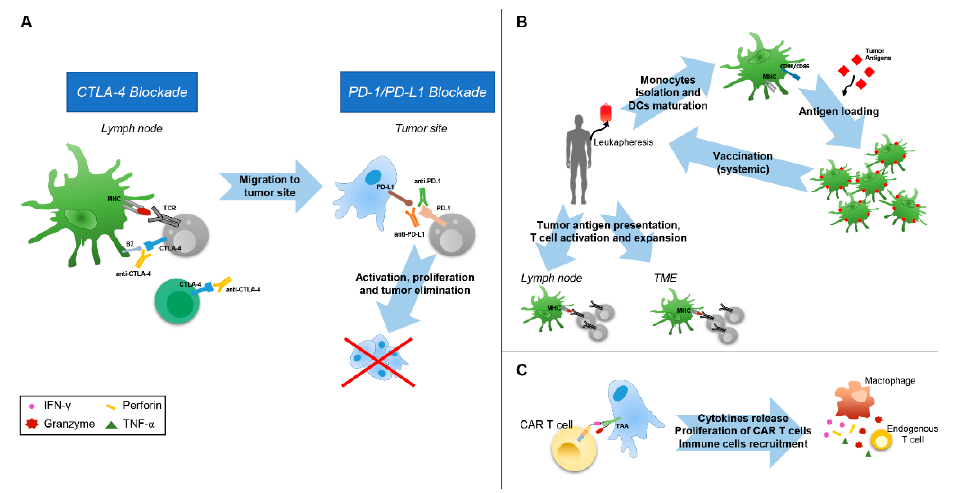
Figure 2. Mechanisms of action of immunomodulating agents. ( A ) CTLA-4 and PD-1 pathway blockade. CTLA-4 blockade allows activation and proliferation of tumor-specific T cells and reduces Treg-mediated immunosuppression. PD-1 pathway blockade reestablishes the activity of quiescent tumor-specific T cells and stimulates T cell migration and proliferation. ( B ) To generate DC cancer vaccines, DCs are harvested from patients by leukapheresis, maturated ex vivo and, in some cases, loaded with tumor antigens before reinfusion into patients. At TME and lymph node levels, DCs present tumor antigens to tumor-specific T cells, resulting in T cell activation and expansion. ( C ) CAR T cells carry modularly constructed fusion receptors that recognize specific antigen on cancer cells; upon binding, the intracellular signaling domains induce signal transduction cascades stimulating antitumor T cell activities. CTLA-4, cytotoxic T-lymphocyte–associated antigen 4; DC, dendritic cell; MHC, major histocompatibility complex; PD-1, programmed death 1; PD-L1, programmed death ligand 1; TCR, T-cell receptor; TAA, Tumor associated Antigen.